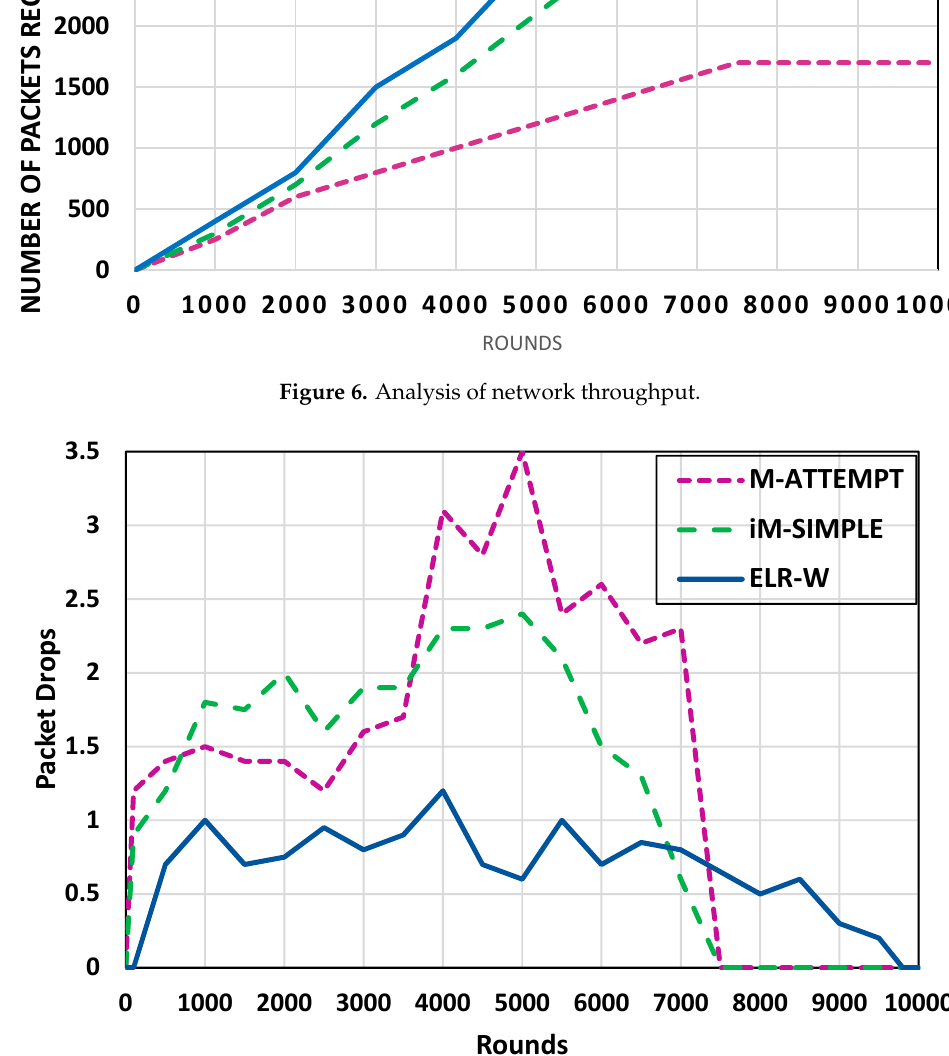
Figure 7. Analysis of packet drops.